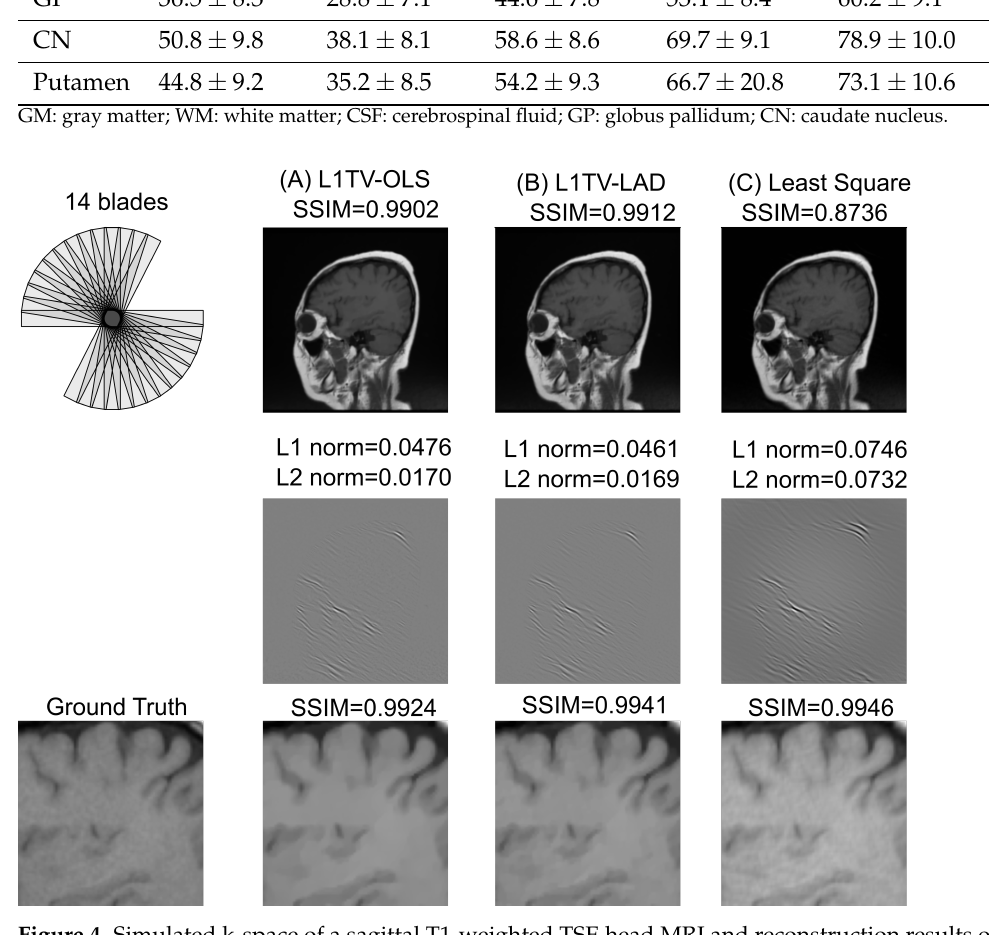
Figure 4. Simulated k-space of a sagittal T1-weighted TSE head MRI and reconstruction results of 3 algorithms. The k-space has 14 blades (70% coverage of the fully sampled k-space), which can occur when 30% of the blades are corrupted due to patient movement. Simulated data are reconstructed by three algorithms ( A ) the L1TV-OLS, ( B ) the L1TV-LAD, and ( C ) the least squares. Overall, L1TV-LAD achieves lower L1/L2 norm than the L1TV-OLS or least-squares, without stair-casing artifacts or cartoon-like over-smoothed image quality. Least-squares causes a higher L1/L2 norm and obvious artifacts in the difference map. The zoom-in of the imagery by 3 algorithms shows similar SSIM values (SSIM =